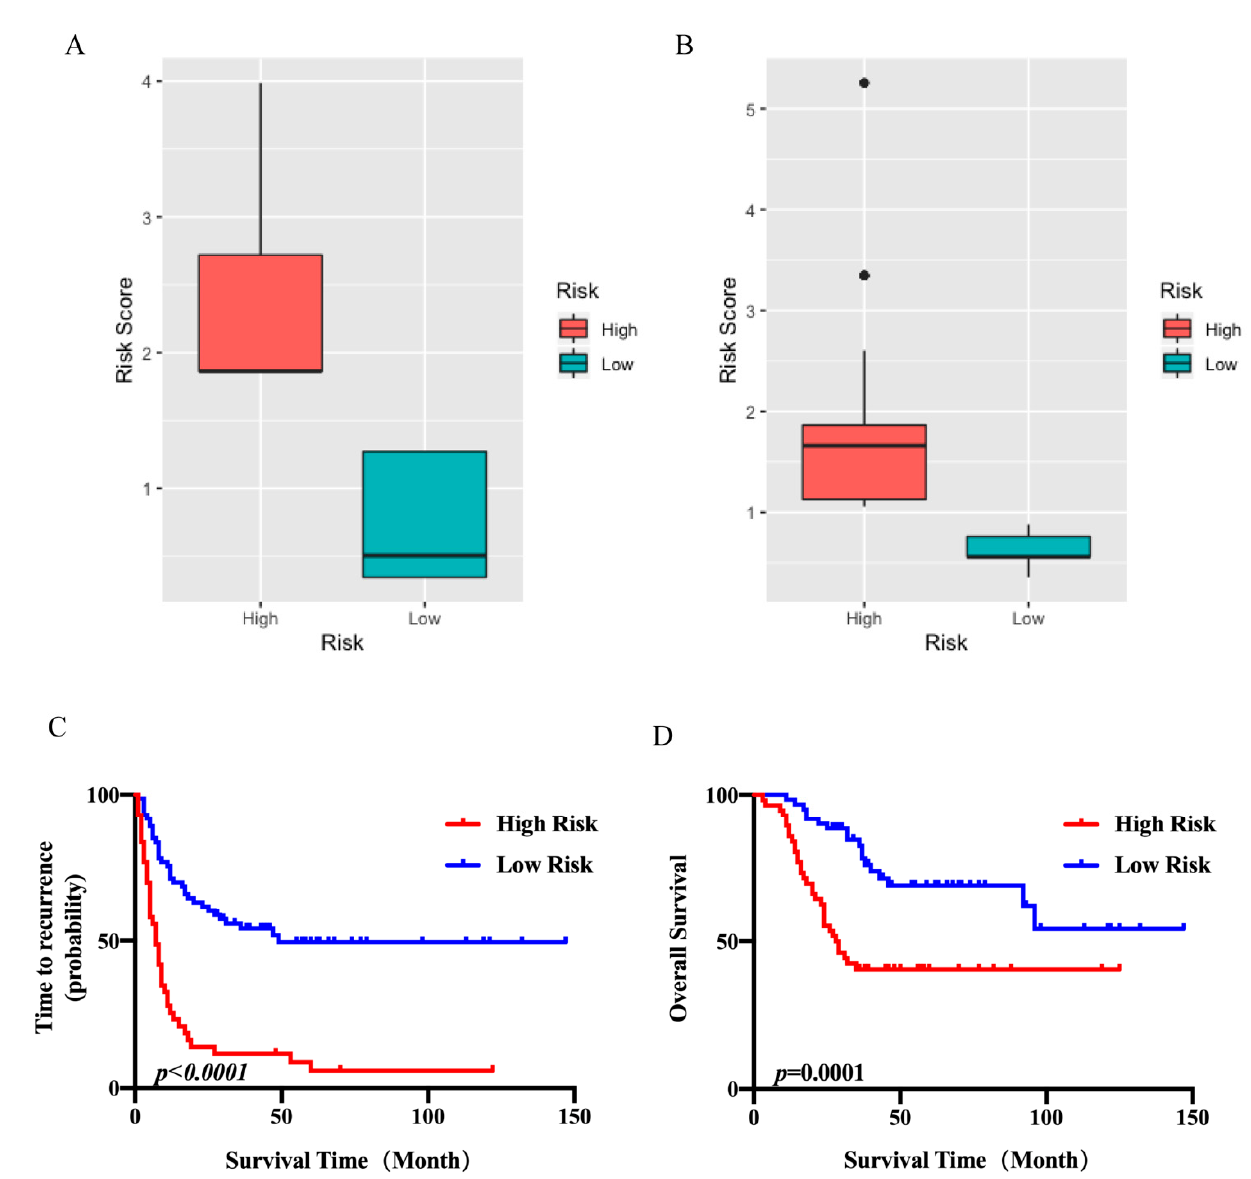
Figure 5. Prognostic role of risk score in UPS. ( A ) The relationship between TTR risk classifications and risk score. ( B ) The relationship between OS risk classifications and risk score. ( C ) Kaplan–Meier analysis of TTR according to TTR risk classifications. ( D ) Kaplan–Meier analysis of OS according to OS risk classifications.